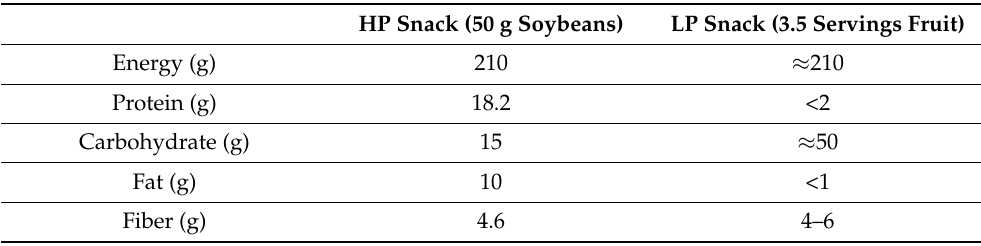
Table 1. Characteristics of the soy enriched high and low protein snack meal. Abbreviations: HP, high protein; LP, low protein; g,